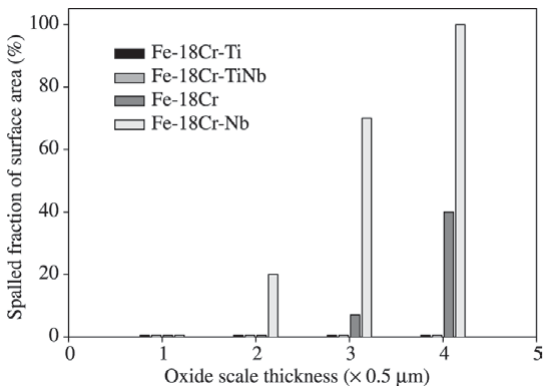
Figure 1. Oxide spallation average data at cooling after isother- mal oxidation in oxygen as a function of scale thickness for the ferritic grades under study (substrate thickness: 0.15 mm).